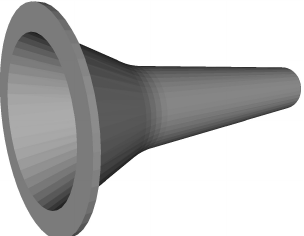
Figure 7. 3-D rendering of a 3-D printable sausage funnel.